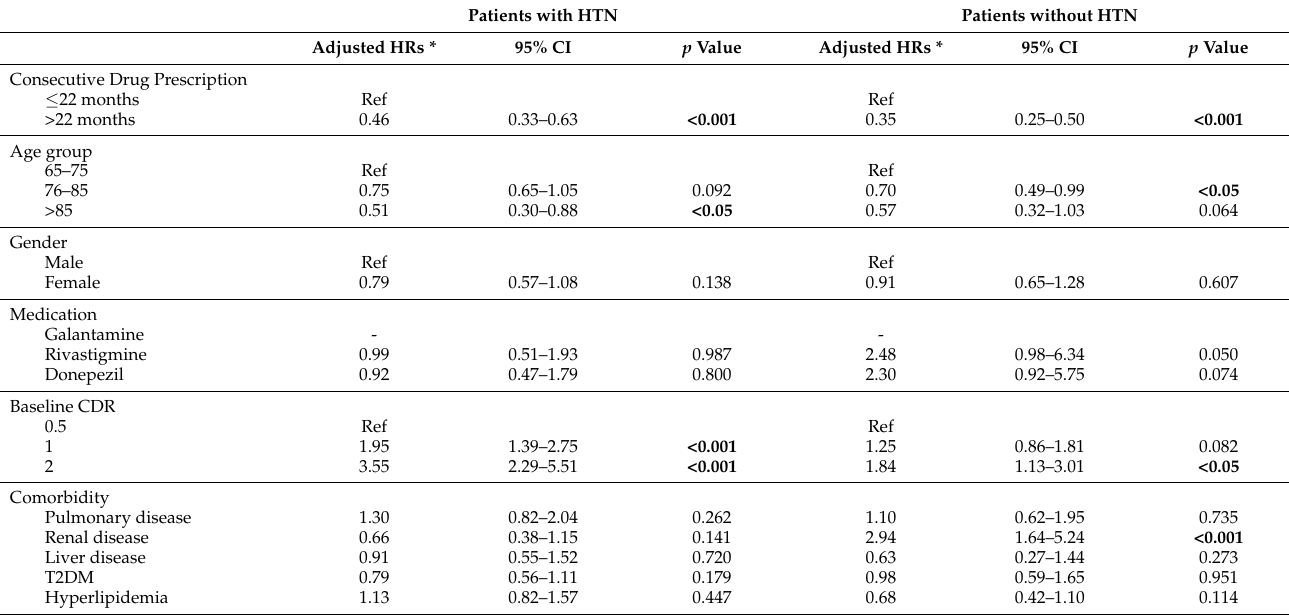
Table 5. Cox proportional hazards model for rapid decline within 2 years in patients with Alzheimer’s dementia with hypertension and without